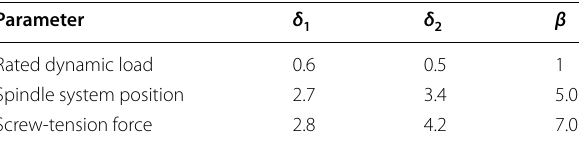
Table 4 Comparison of overall variation ( δ ) and maximum percentage discrepancy ( β ) Parameter δ